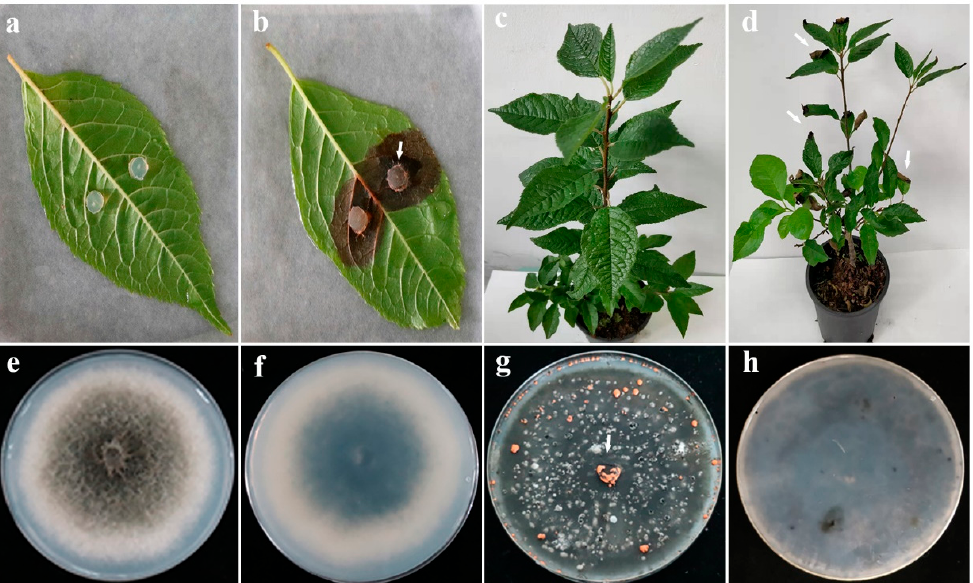
Figure 2. Symptoms of winterberry holly leaves after incubation with isolate LVY 9. In vitro in- oculation, brown necrotic lesions with bright orange conidial masses appear ( b ) compared with control ( a ) after 7 days. The arrow points to orange conidia ( b ). In spray inoculation, grayish brown spots appear on tips of leaves with obvious curly phenotype compared with control ( c ) after 30 days. The arrow points to irregular spots ( d ). The mycelia are grayish brown with white edge ( e ) and reserve is turquoise ( d ) after strain LVY 9 on PDA for 7 d. Orange masses of conidia released from pycnidia after strain LVY 9 under a mixture of fluorescent white and UV light on PDA 20 d ( g , h ). The arrow points to orange conidia ( g ). Strain LVY 9 resembles Colletotrichum gloeosporioides by SEM and light microscopy.